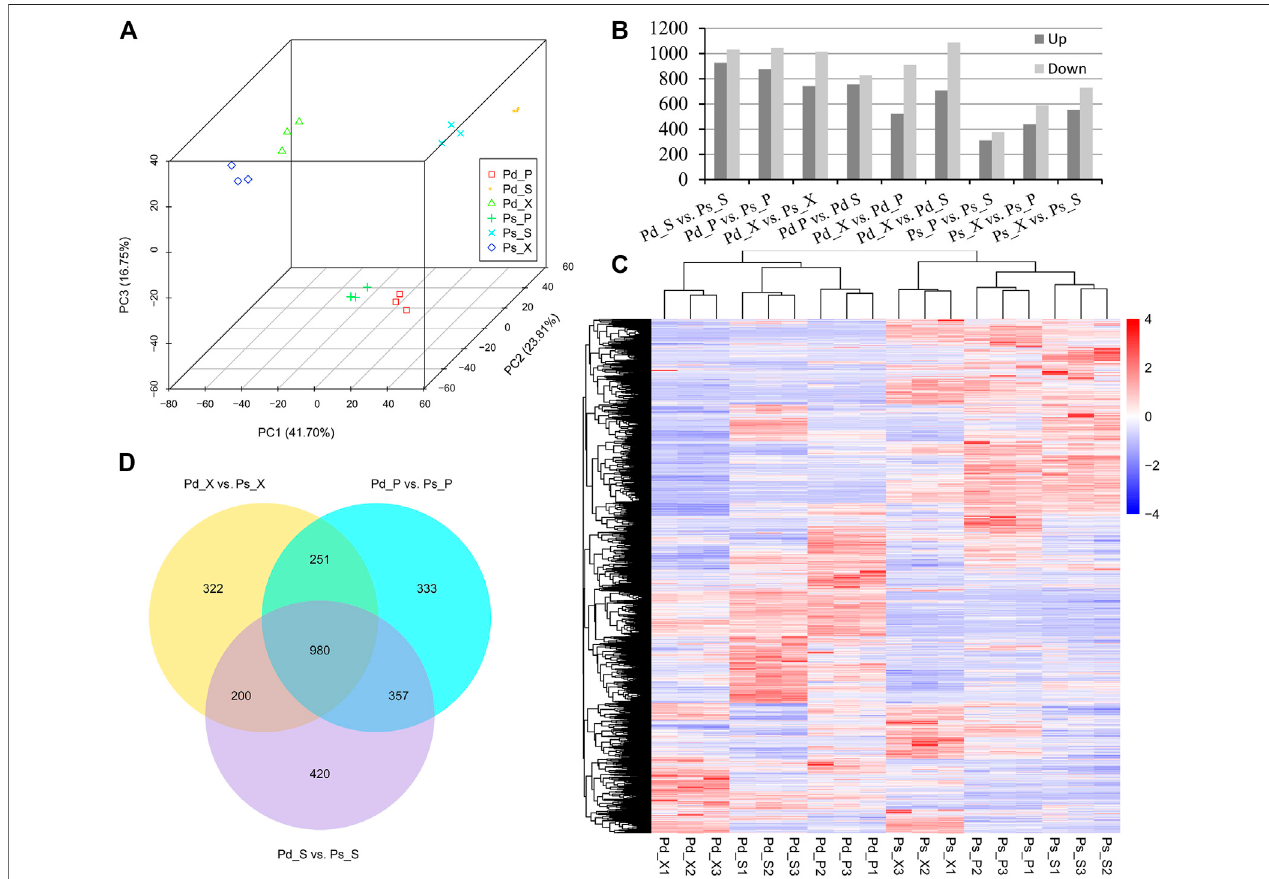
FIGURE 3 | Differentially expressed (DE) lncRNAs identi fi ed in pair-wise comparison of 18 samples. (A) Principal component analysis (PCA) 3D of the expressed genes showing sample separation. (B) Number of DElncRNAs in different comparisons. (C) Heat map of DElncRNAs in the two genotypes. (D) Venn diagram showing DElncRNAs of Pd_X_vs_Ps_X, Pd_P_vs_Ps_P, and